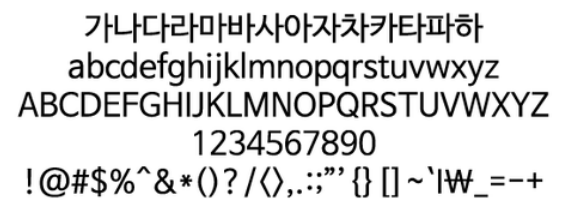
Figure 5. Nanum-Bareun